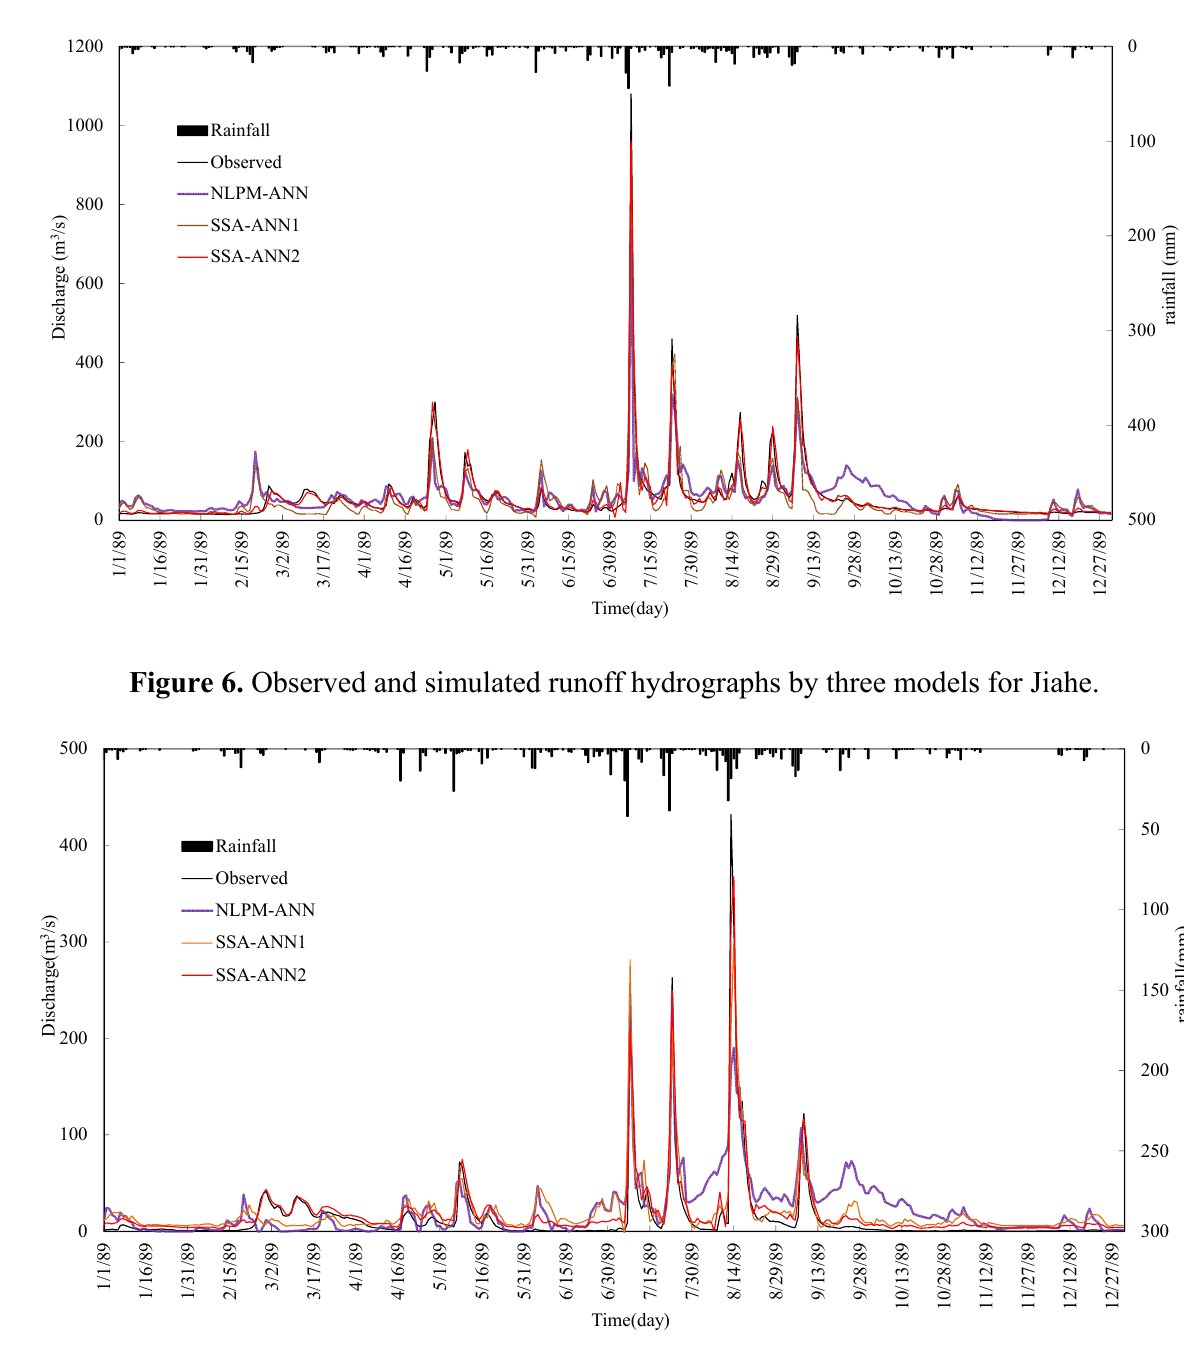
Figure 7. Observed and simulated runoff hydrographs by three models for